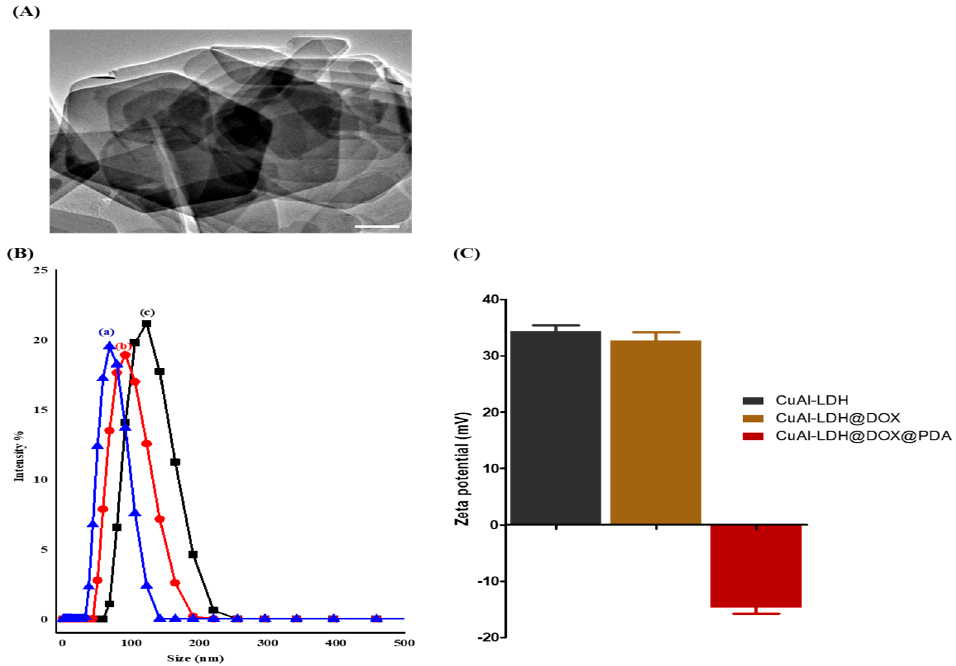
Figure 1. ( A ) TEM images of as-synthesized CuAl-LDH (scale bar 100 µm), ( B ) zeta size of (a) CuAl-LDH, (b) CuAl-LDH@DOX, and (c) CuAl-LDH@DOX@PDA, and ( C ) zeta potential of CuAl-LDH,